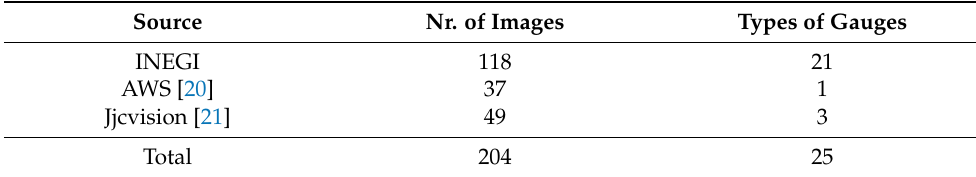
Table 1. Dataset